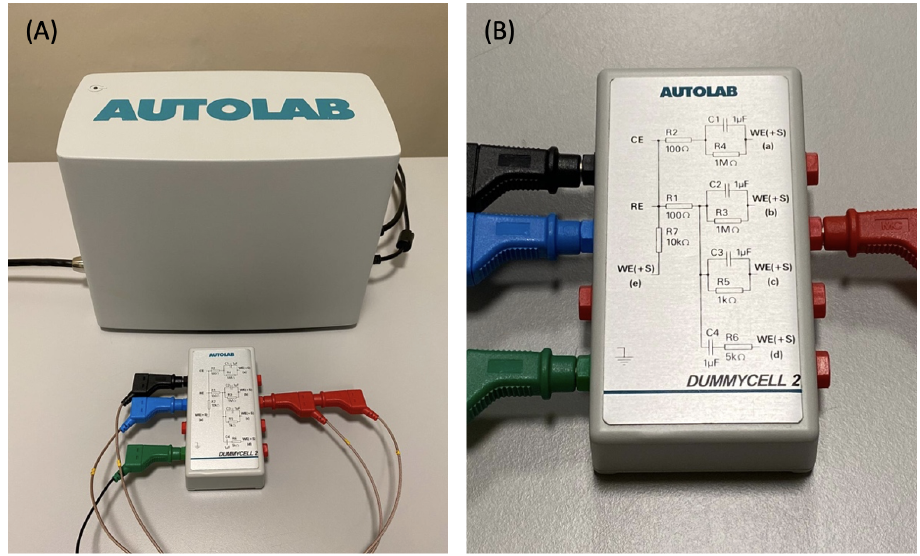
Figure 3. Autolab PGSTAT potentiostat/galvanostat equipment ( A ) connected to the dummy cell ( B ) containing the